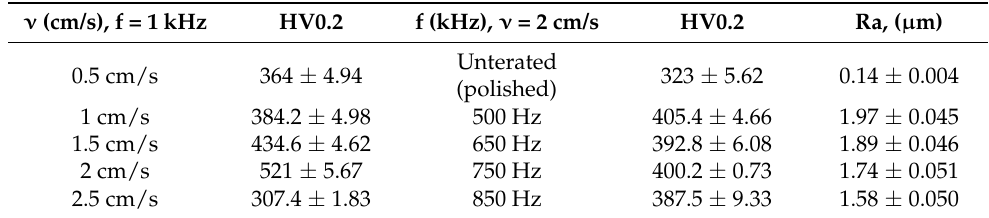
Table 2. Hardness and roughness values of TiAl6V4 substrate before and after treatment via different speed of sample motion ( ν ) and scanning frequency (f) of the electron